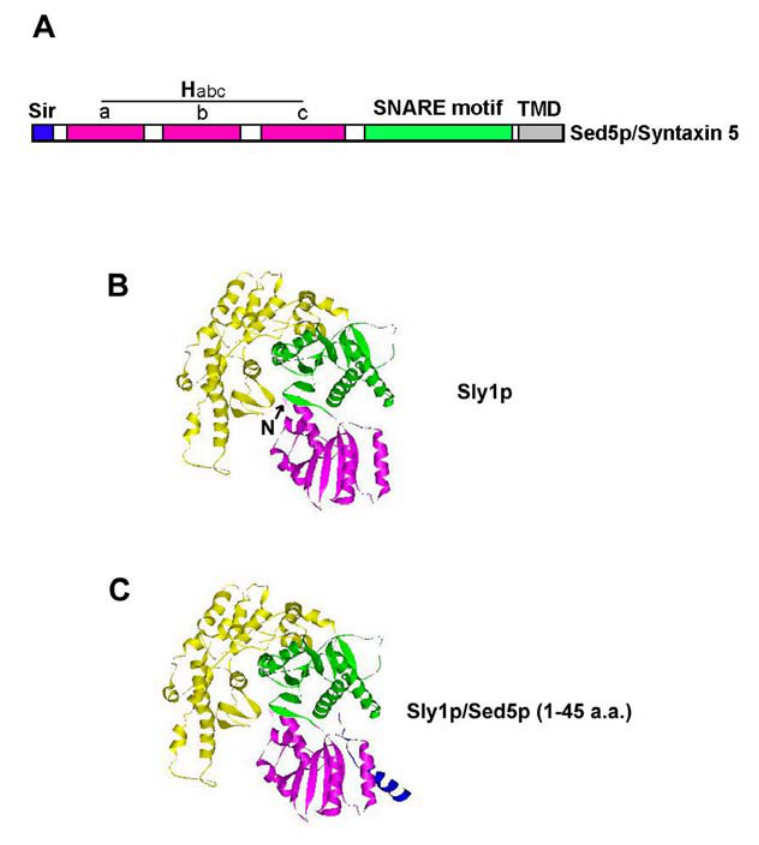
FIGURE 1. The interaction of the Golgi syntaxin 5 (Sed5p) and its cognate SM protein Sly1p. (A) Yeast Sed5p and its mammalian homolog syntaxin 5 are characterized by the SNARE motif at the C-terminal proximity and the α -helix a, b, and c, collectively termed Habc domain at the N-terminus. The Sly1p-interacting region (Sir), a stretch of around 20 residues, is located at the very tip of the N-terminal Sed5p. TMD, transmembrane domain. (B) Structure of Sly1p. Sly1p folds into a three-domained (I, II, and III, decorated in red, green, and yellow, respectively), arch-shaped assembly. (C) Structure of Sly1p in complex with the N-terminal 45 amino acids of Sed5p. Sed5p (blue) directly contacts with domain I of Sly1p. The binding region for nonsyntaxin SNAREs is different from that for Sed5p, but it has not been mapped on Sly1p yet. Fig. 1B and 1C were generated from pdb data using ViewerLite 4.2